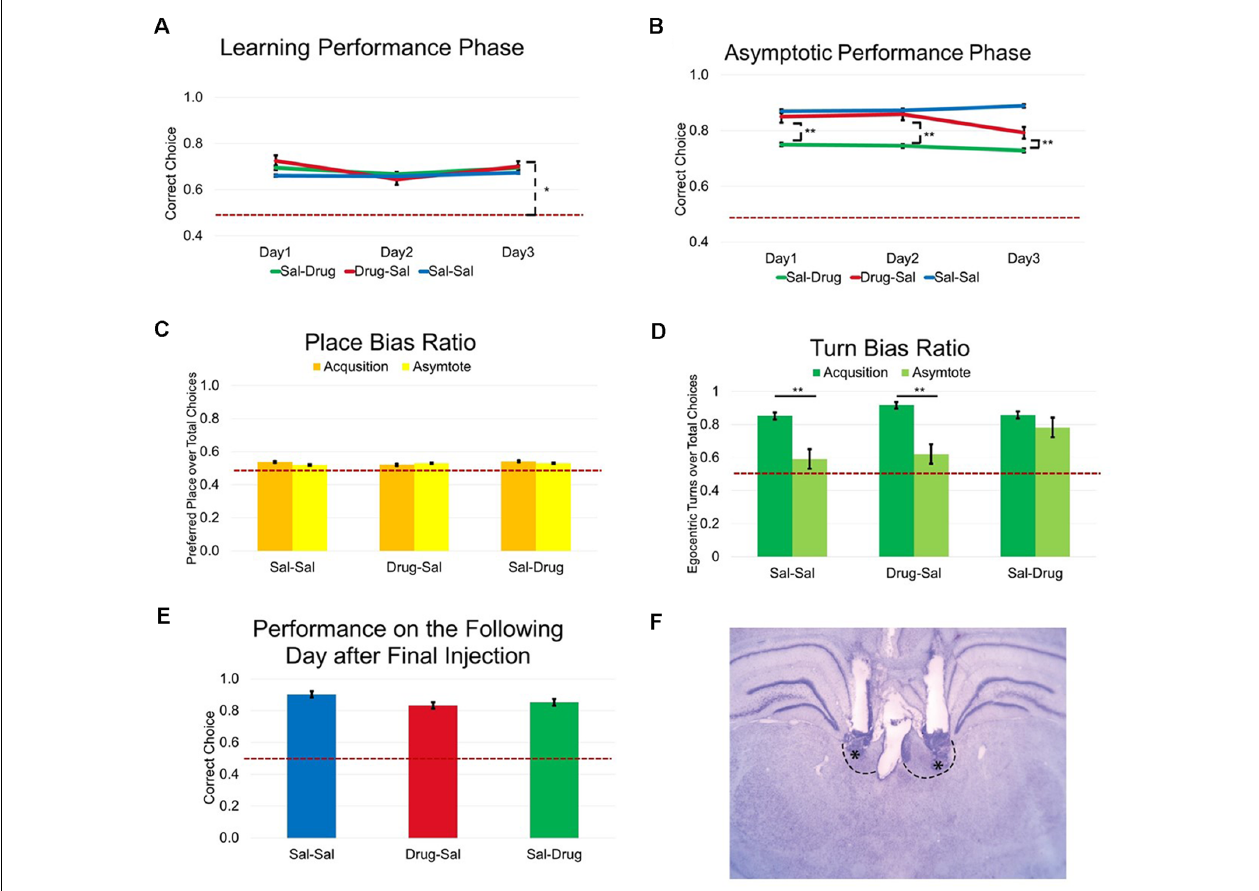
FIGURE 3 | Experiment 1: LHb inactivation impairs learned spatial delayed-alternation but does not alter initial learning. (A) Drug treated animals are more accurate than would be expected by chance ( t ( 2 ) = 7.94, p < 0.05). (B) LHb inactivation altered flexible performance of a learned behavior performed at asymptotic levels. (C) No effects of treatment group ( F ( 2,16 ) = 0.80, ns.), learning phase ( F ( 1,16 ) = 1.01, ns.), or interaction ( F ( 2,16 ) = 1.55, ns.) were observed according to a two-way ANOVA on the ratio of preferred place location over the total number of choices during a session. (D) Examination of egocentric turn bias using a two-way ANOVA revealed a significant effect of treatment group ( F ( 2,16 ) = 5.11, p < 0.05), learning phase ( F ( 1,16 ) = 38.26, p < 0.01), and a significant interaction ( F ( 2,16 ) = 4.23, p < 0.05) on the ratio of preferred egocentric turn direction over the total number of choices during a session. Bonferroni post hoc tests showed that the turn bias ratio was significantly lower during asymptotic performance for the Sal-Sal and Drug-Sal groups but not for the Sal-Drug group ( p < 0.01). (E) A one-way ANOVA revealed a similar level of performance accuracy following the final day of asymptotic testing, F ( 2,16 ) = 3.03, ns. ranging from (80.79 ± 3.32) in the Drug-Sal group to (90.28 ± 1.69) in the Sal-Sal group. (F) Cannula placements in the LHb. ∗ p < 0.05. ∗∗ p < 0.01. ns = not significant.